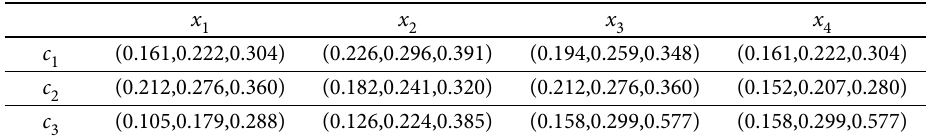
Table 6. Normalized fuzzy decision matrix